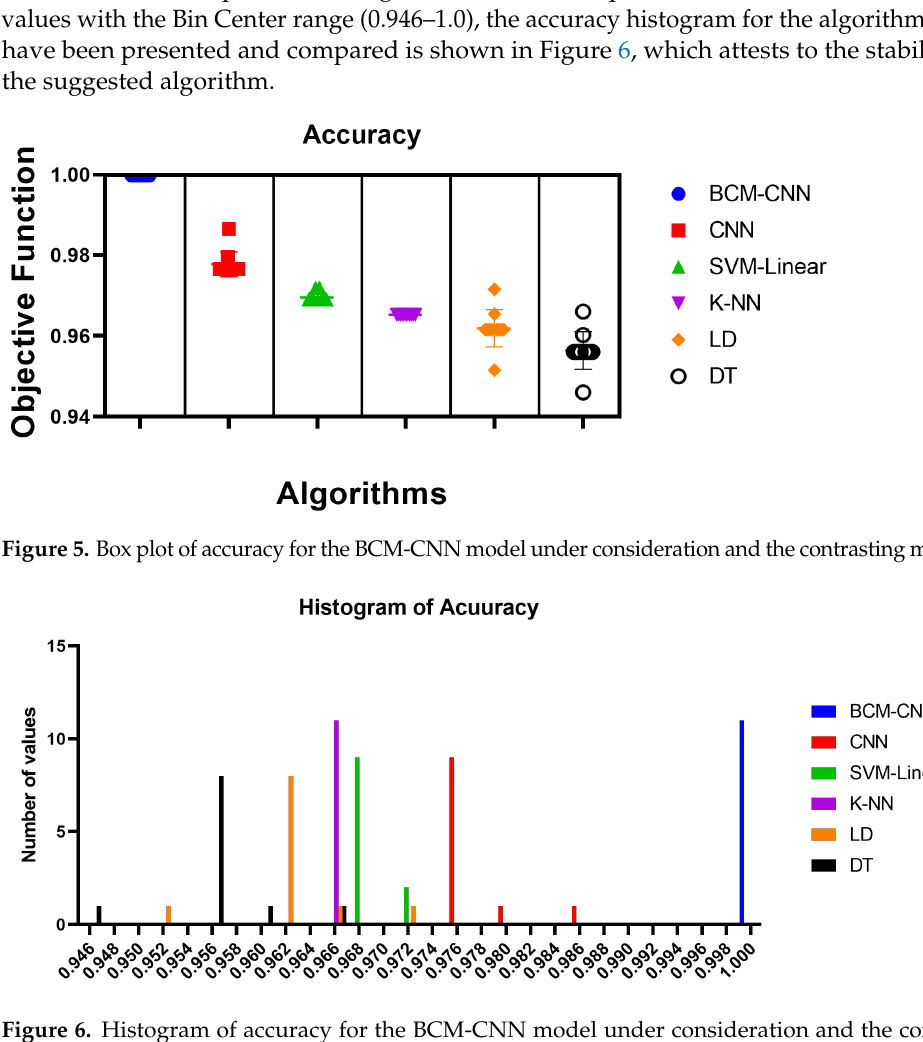
Figure 6. Histogram of accuracy for the BCM-CNN model under consideration and the contrast- ing